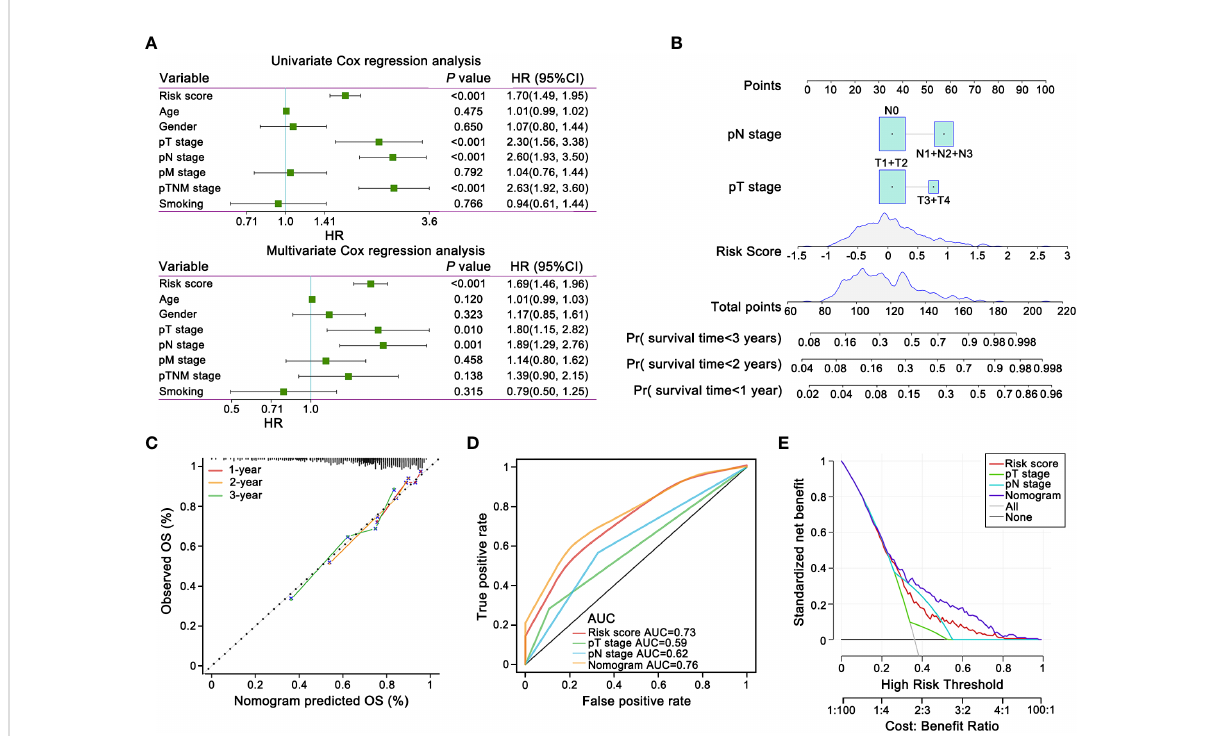
FIGURE 5 The prognostic nomogram and decision curve analysis (DCA) of the risk score based on E-signature. (A) The forest plot showed that the signature was independent from other risk factors for prognostic prediction. (B) Nomogram predicted risk of secondary progression. Each variable axis, containing T stage, N stage and risk score, corresponded to the characteristic attribute score of single sample. The fi nal score was summarized on the total score axis and the likelihood of 1-, 2-, and 3 years OS is determined on the survival axis. (C) The nomogram yielded an accurate predictive capability that was extremely close to actual survival was presented by the calibration plots. X-axis represented the predicted value of survival probability and y-axis represented actual survival possibility. (D) ROC curves represented that the E-signature ranked fi rst among all the parameters. (E) DCA curves graphically veri fi ed the E-signature brought more net bene fi t of survival than other clinical indexes. Solid lines indicated net bene fi t of the predictive model within the threshold probabilities range. The black and grey line respectively represented the hypothesis that none or all patients would